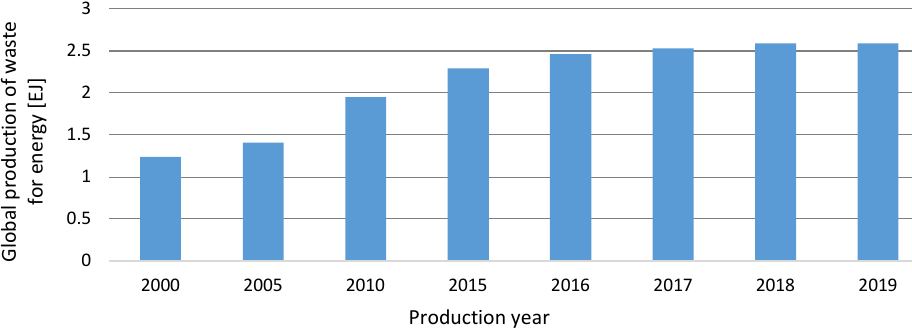
Figure 9. Global production of waste for energy (2000–2019) [34].